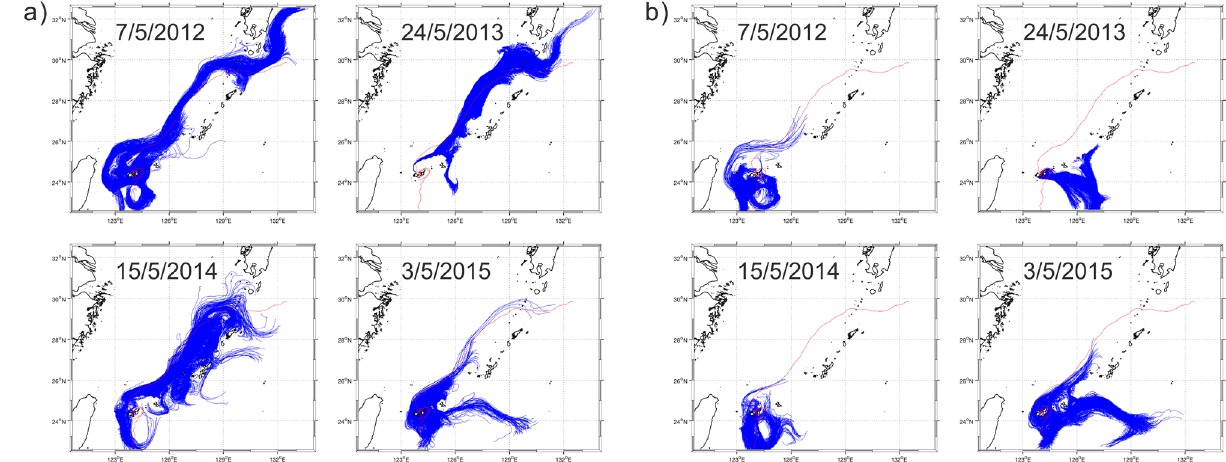
Figure 10. Trajectories of particles discharged from ( a ) the northern coast of Hatoma Island and (b) Urabishi reef during the years 2012–2015. Dates at the top of each map show the first particle discharge day in each year, and red lines indicate the trajectory of a drifter buoy observed during 2006 that followed the Kuroshio Current 4